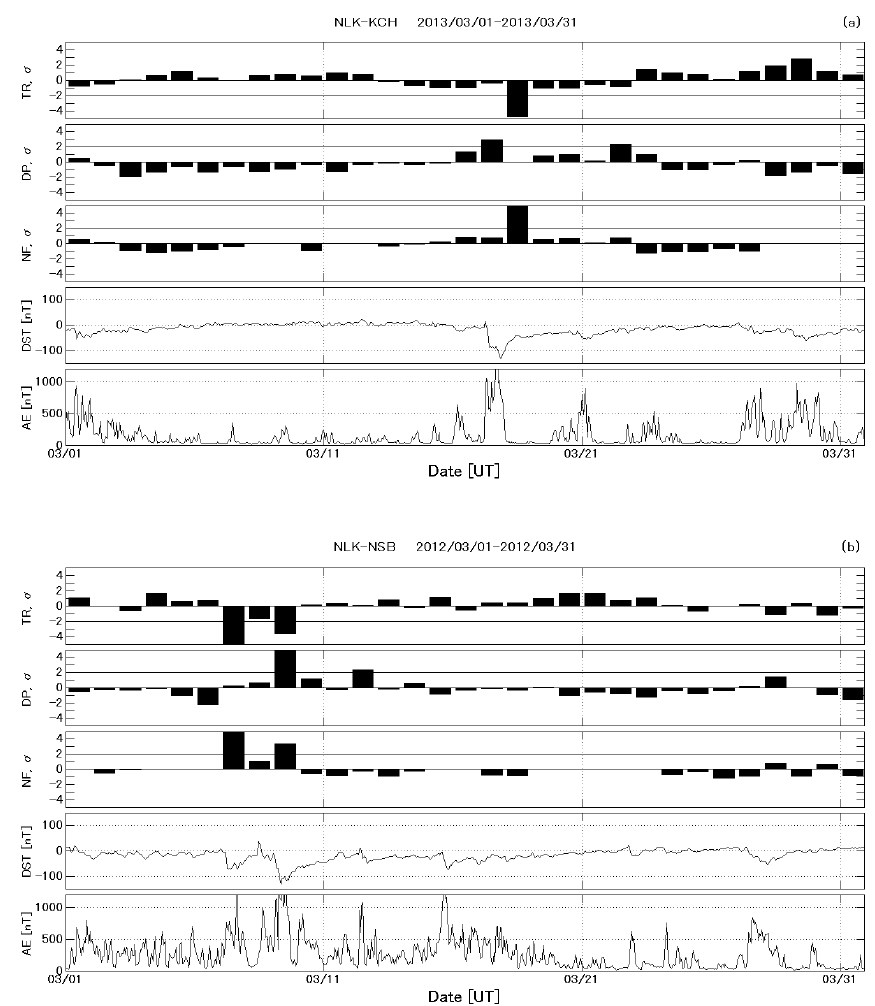
Figure 3. (a) Daily variations of VLF subionospheric propagation (three panels from the top), Dst (fourth panel) and AE indices (fifth panel) around a single (isolated in time) geomagnetic storm. Three statistical parameters for VLF propagation characteristics are trend (TR), dispersion (DP), and nighttime fluctuation (NF) from the top. (b) Same type of variation as (a) but for multiple geomagnetic storms (several storms occurred closely in